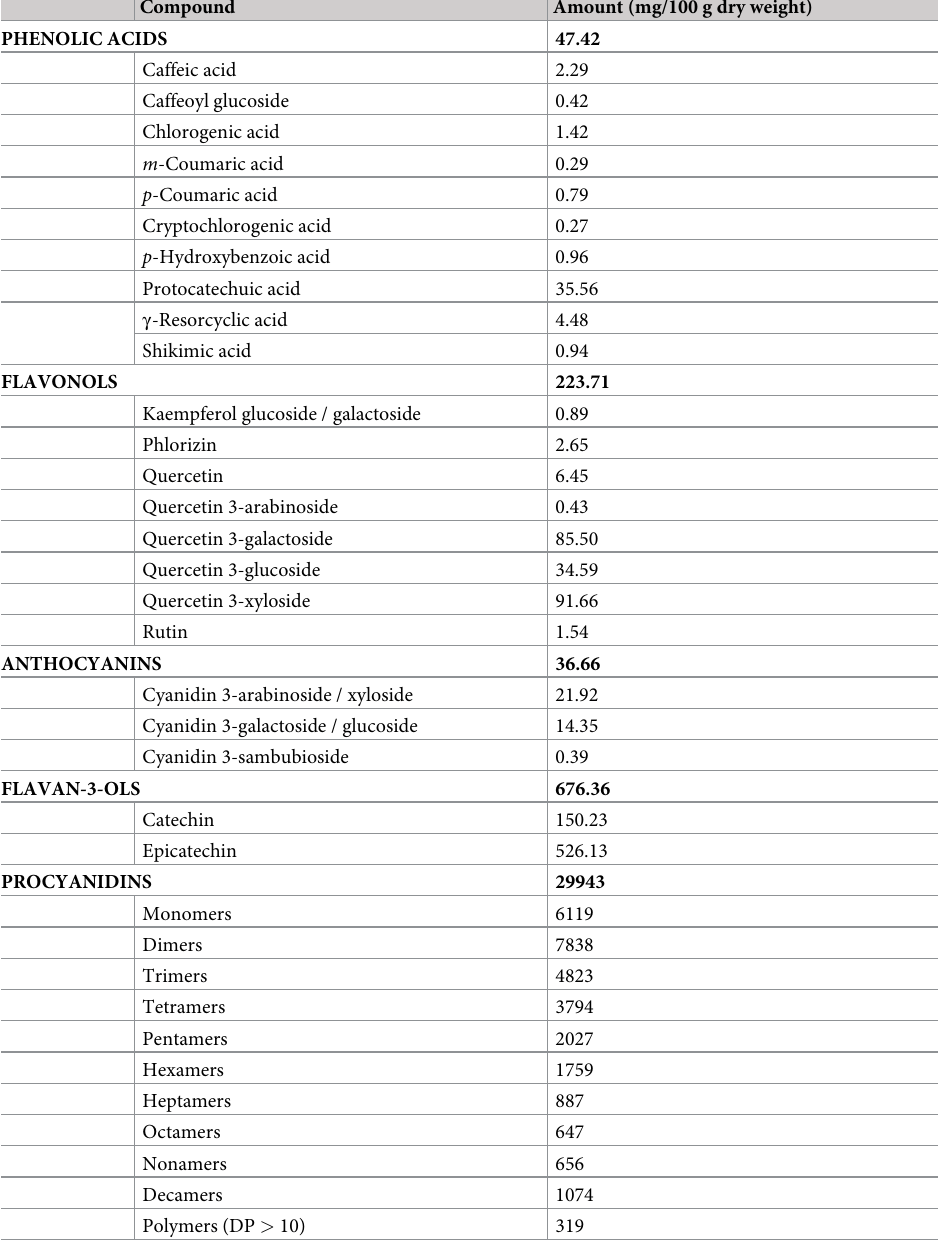
Table 1. Phenolic composition of the cocoa